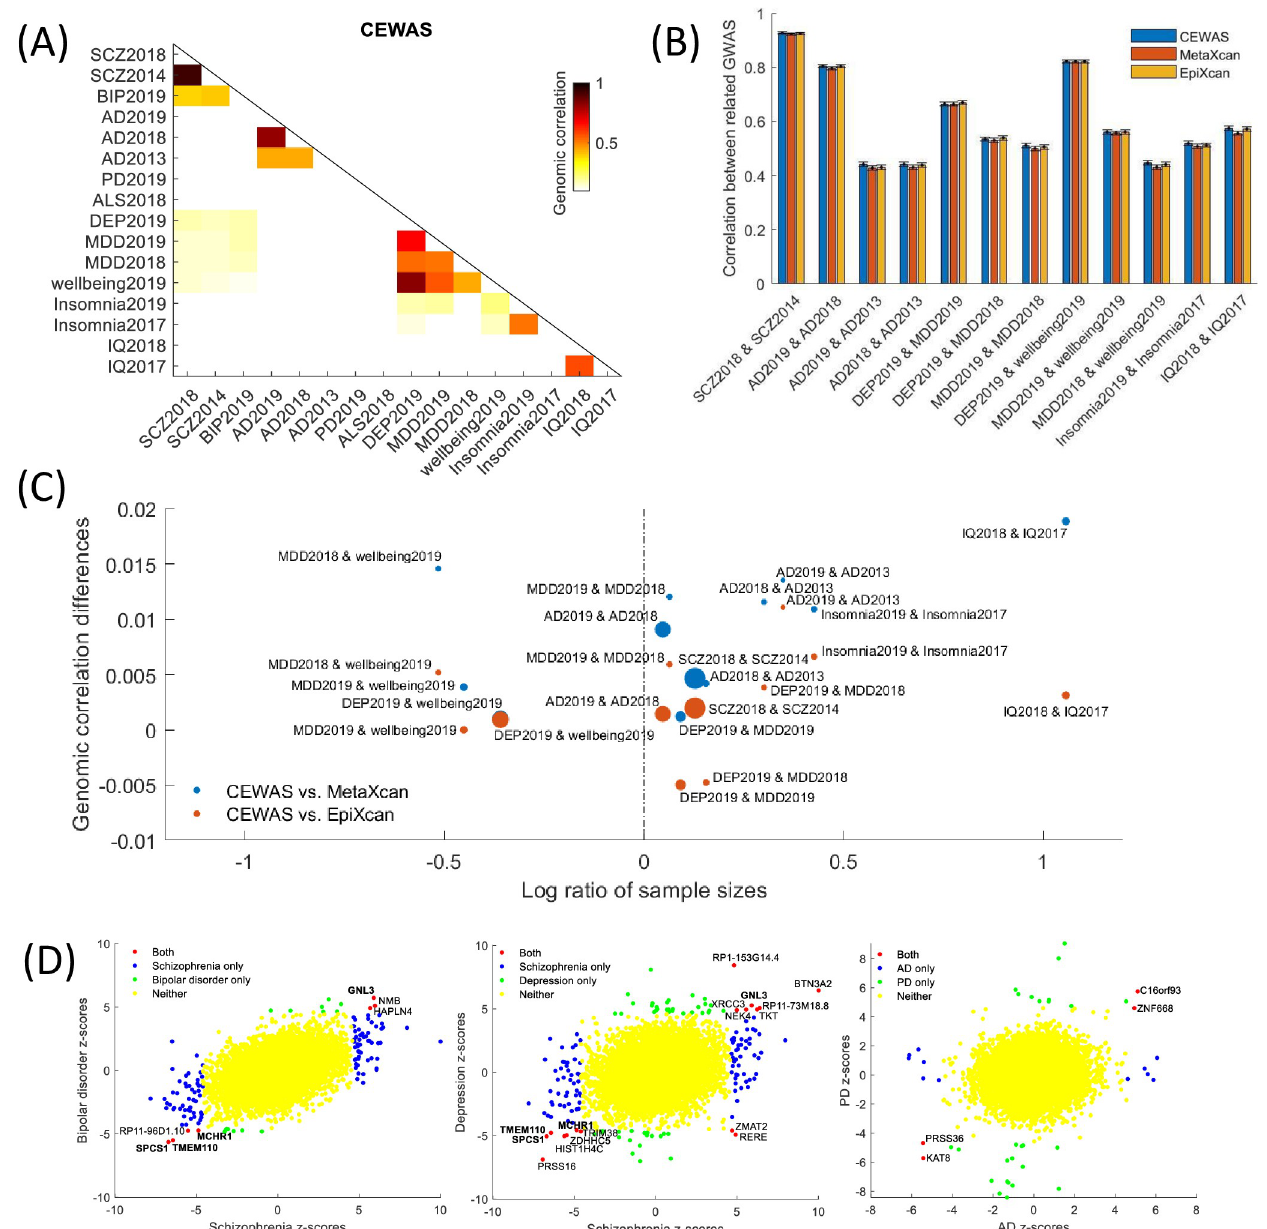
Fig 3. Genomic correlation across GWAS. (A) Correlation between CEWAS-derived z-scores for all GWAS pairs shown (values clipped at 0.1 to highlight higher correlation). (B) Correlations between gene level z-scores for GWAS pairs of the same phenotype displayed. Note that wellbeing spectrum is partly based on depressive symptoms, hence wellbeing2019 is expected to be highly correlated with DEP2019, MDD2019, and MDD2018. (C) Dissecting results in panel b, log ratio between sample size of GWAS pairs is plotted against differences in genomic correlation between CEWAS vs. a contrasted method. The size of a dot corresponds to the correlation between CEWAS z-scores of a GWAS pair. Two trends were observed: i. higher correlations between GWAS pairs with similar sample size (dots closer to 0 on x-axis are larger), ii. CEWAS typically yields higher genomic correlation than the contrasted methods (most dots above 0 on y-axis). (D) CEWAS z-scores of schizophrenia vs. bipolar disorder, schizophrenia vs. depression, and AD vs. PD shown as scatterplots. Genes detected across schizophrenia, bipolar disorder, and depression highlighted in bold. Although AD and PD show little genomic correlation, a few shared genes were